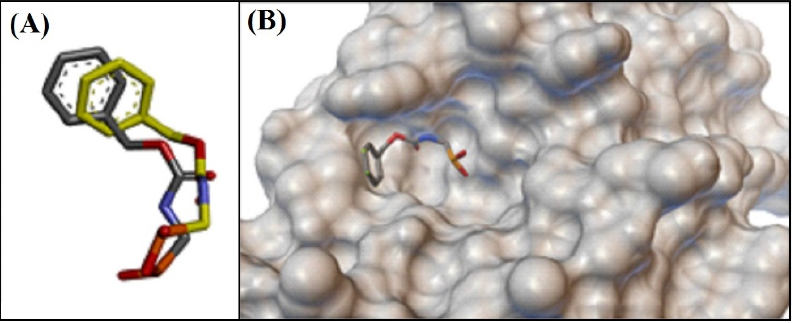
Figure 4. Redocking of the crystallographic ligand at the catalytic site of β -lactamase of S. aureus . ( A ) Crystallographic ligand conformation (moss) and conformation obtained by redocking (gray); ( B ) Ligand at the enzyme site.